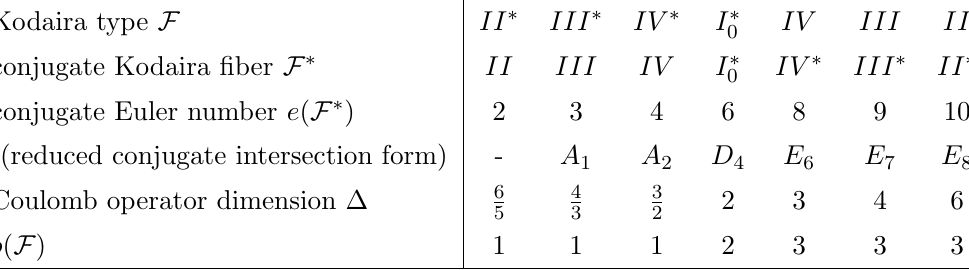
Table 1 . Coarse-grained classi(cid:12)cation of rank-1 SCFT by Kodaira (cid:12)bers of semi-simple type. By the reduced conjugate intersection form we mean the intersection matrix C i (cid:1) C j of the irreducible curves C i (cid:26) F (cid:3) which do not cross the zero-section of the elliptic (cid:12)bration; the Cartan matrix of a simply-laced Lie algebra is denoted by the same symbol as the Lie algebra. Sometimes we use the Lie algebra in the third row to label the Kodaira type of A